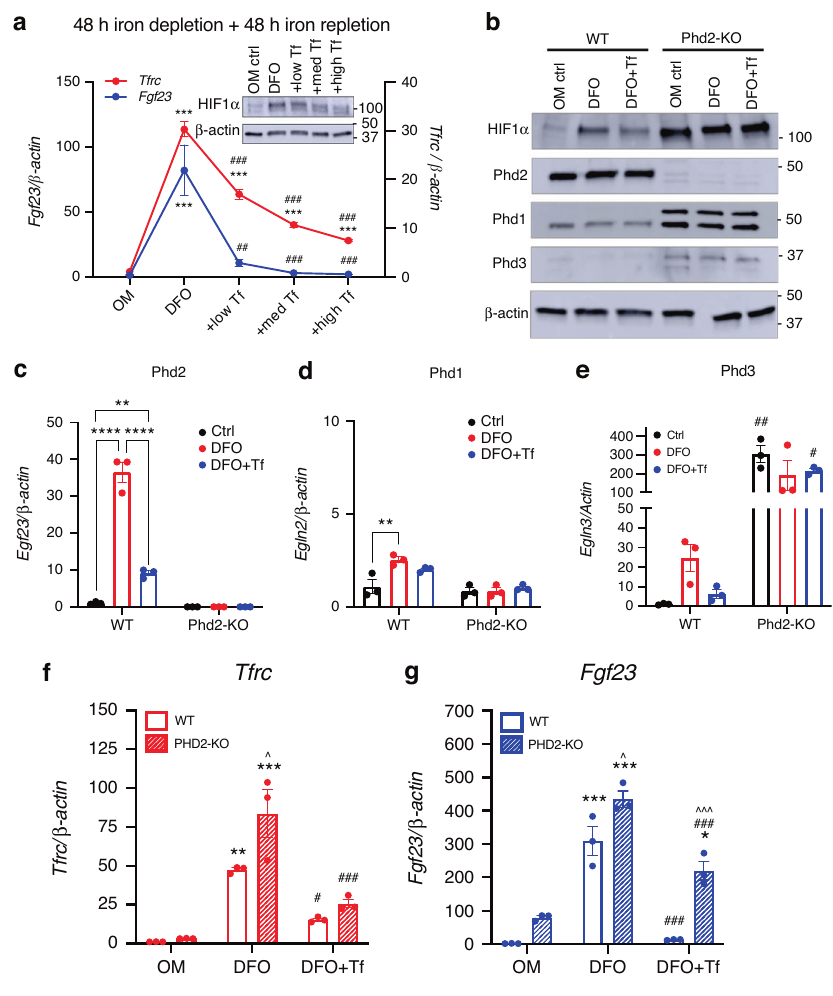
Fig. 5 Phd2 is required for iron-mediated suppression of Fgf23. a Transferrin receptor ( Tfrc ; red) and Fgf23 (blue) expression in WT 3-week differentiated MPC2 cells treated for 48 h with DFO, then repleted with iron using increasing doses of Holo-transferrin (Tf) in DFO-containing media for an additional 48 h (*** P < 0.001 vs. OM ctrl; ### P < 0.001 vs. DFO alone). a inset HIF1 α protein expression in MPC2 cells exposed to iron de fi ciency then repleted with iron using increasing doses of holo-Transferrin (Tf). b HIF1 α , Phd2, Phd1, Phd3, and β -actin protein expression in 3-week differentiated WT and Phd2-KO cells exposed to iron de fi ciency for 48 h then iron repletion with high dose holo-Tf in DFO-containing media for an additional 48 h. c Phd2 ( Egln1 ), d Phd1 ( Egln2 ), and e Phd3 ( Egln3 ) expression in 3-week differentiated WT and Phd2-KO cells exposed to iron de fi ciency for 48 h then iron repletion with high dose holo-Tf in DFO-containing media for an additional 48 h (** P < 0.01, **** P < 0.000 1; # P < 0.05, ## P < 0.01 vs. genotype, same treatment). f Tfrc and g Fgf23 expression in 3-week differentiated WT (solid bars) and Phd2-KO (dashed bars) cells exposed to iron de fi ciency for 48 h then iron repletion with high dose holo-Tf in DFO-containing media for an additional 48 h (** P < 0.01; *** P < 0.001 vs. OM ctrl, same genotype; # P < 0.05, ### P < 0.001 vs. DFO, same genotype; ^ P < 0.05,^^^ P < 0.001 Phd2-KO vs. WT, same